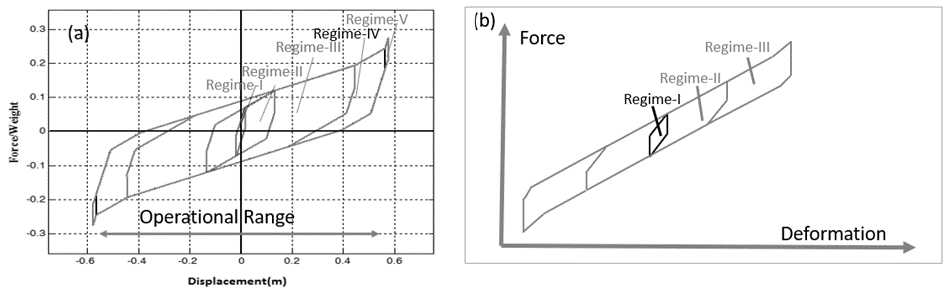
Figure 13. Force-deformation relationship of the MSFS with five ( a ) and three regimes ( b ) .